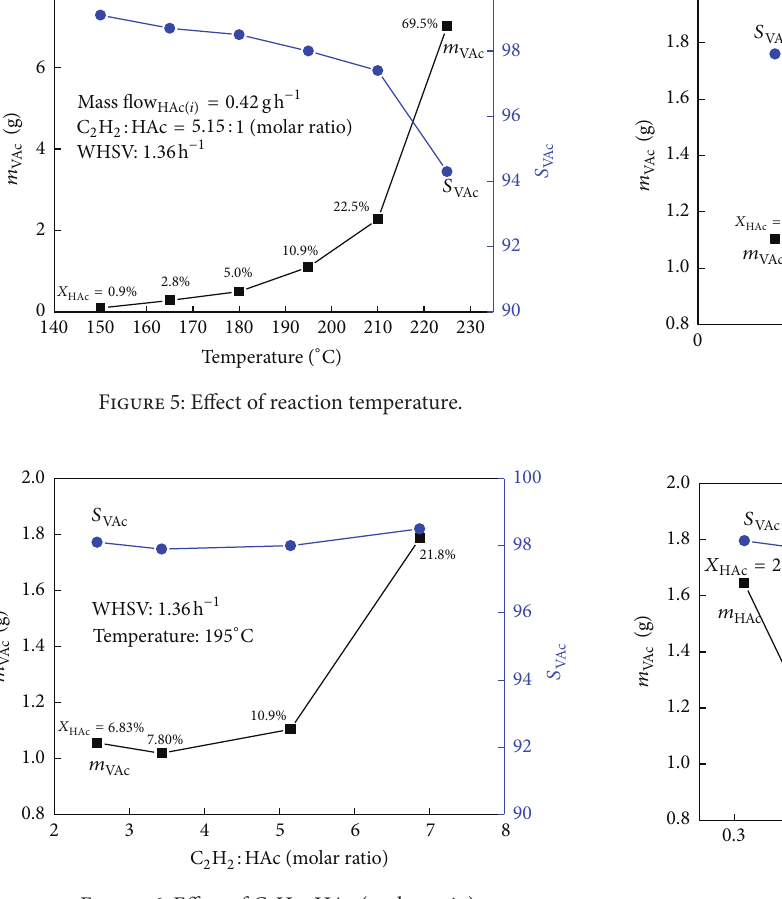
Figure 6: Effect of C 2 H 2 :HAc (molar ratio).